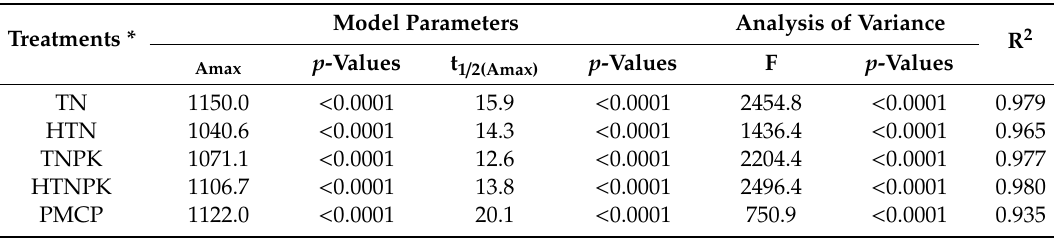
Table 5. Estimation model for PO 4 -P release from di ff erent types of the blended biochar pellet.